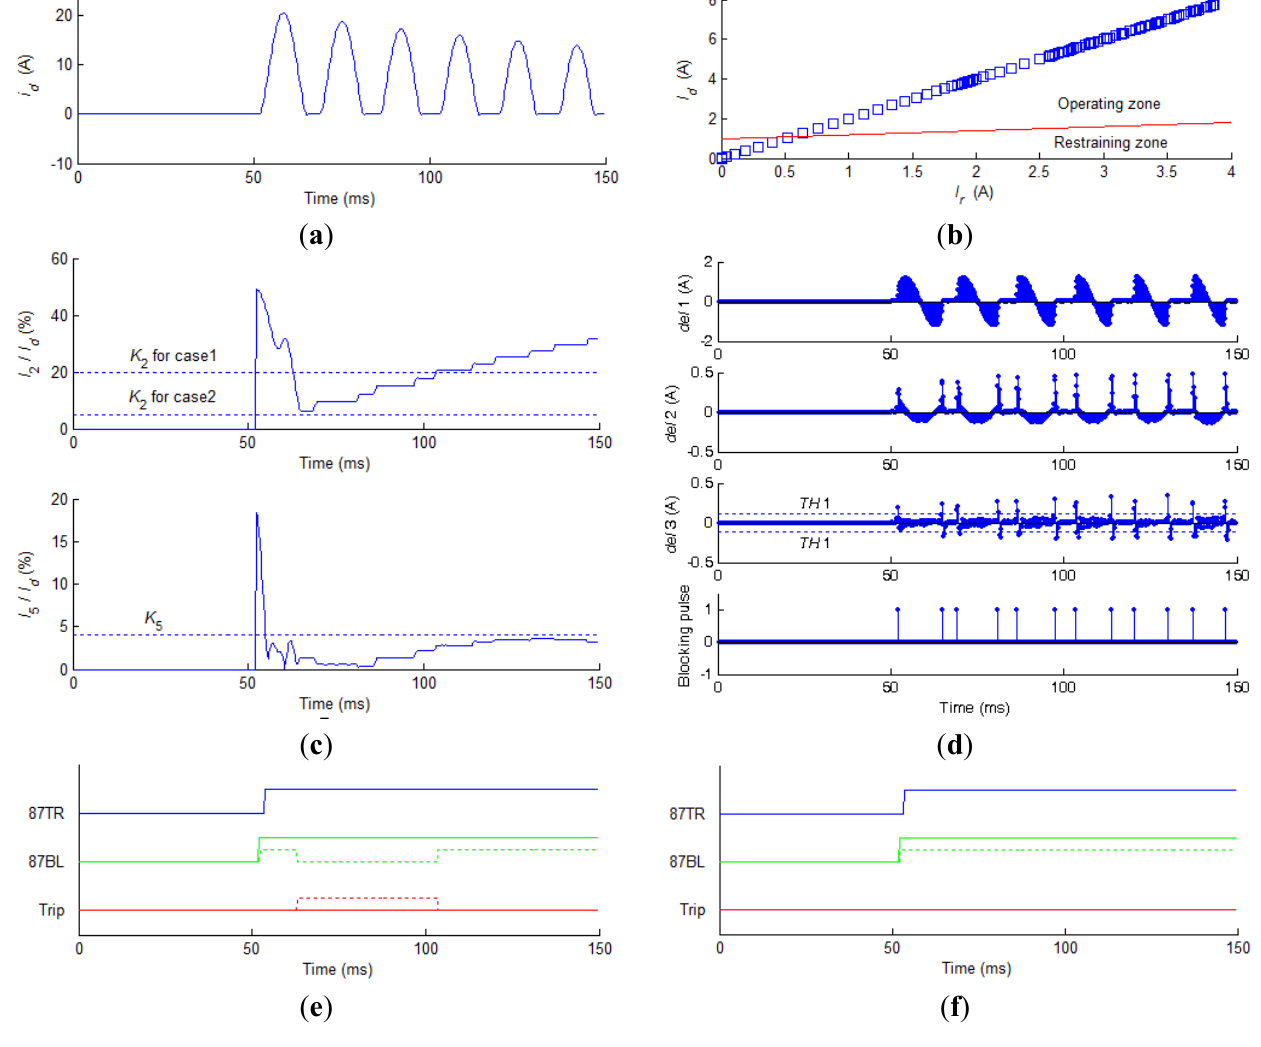
Figure 6. Results for Cases 1 and 2: ( a ) i ( d ) del 1[ n ], del 2[ n ] and del 3[ n ] of i for Case 1; and ( f ) 87TR, 87BL, and trip signals for Case